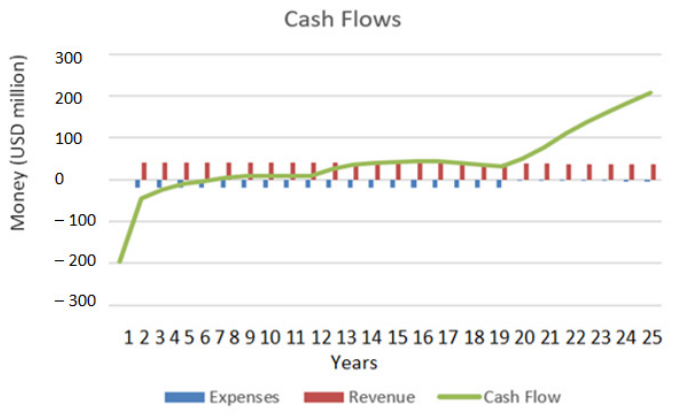
Figure 20. Cumulative cash flow chart for Falls of Rough solar farm Figure 20 . Cumulative cash flow chart for Falls of Rough solar farm [30].